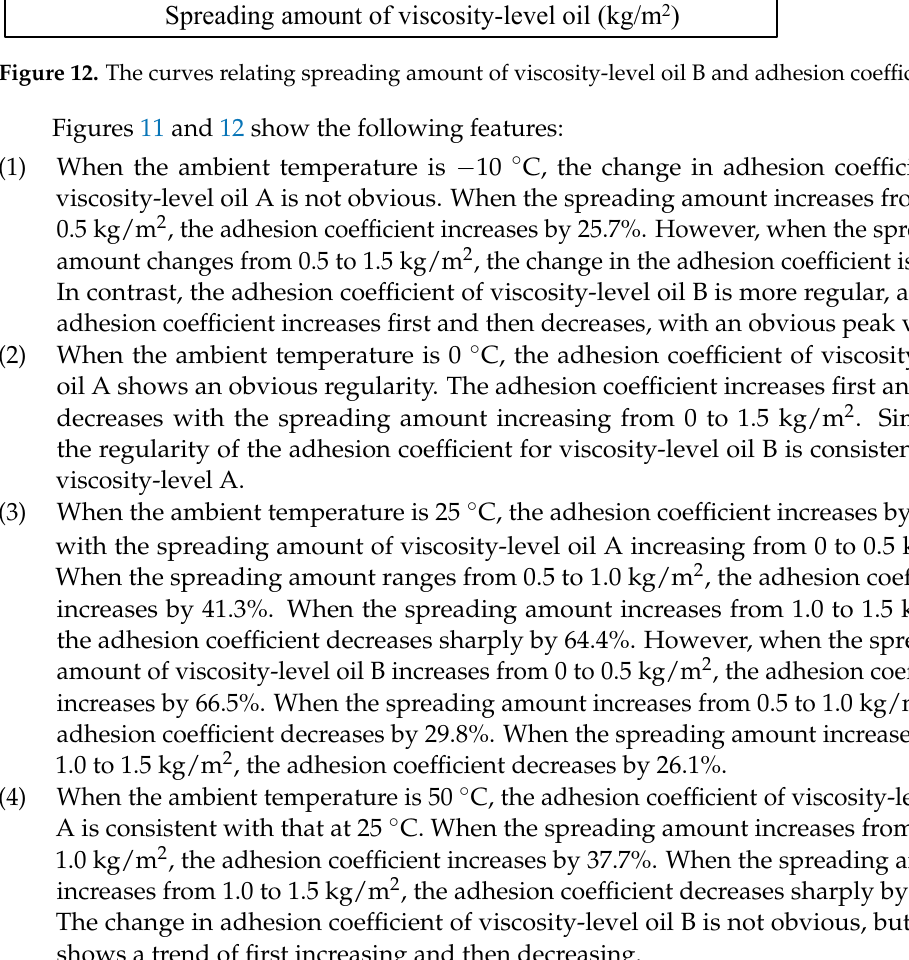
Figure 12. The curves relating spreading amount of viscosity-level oil B and adhesion coefficient.